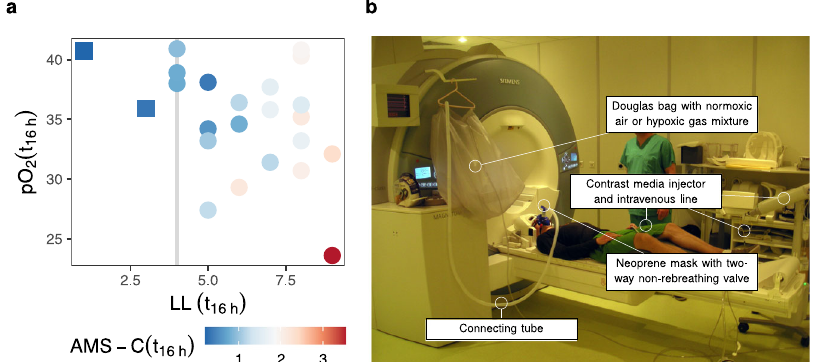
Fig. 3 Exposure to low atmospheric oxygen and acute mountain sickness (AMS). a Single participants ’ arterial oxygen levels (pO 2 ) as a function of their Lake Louise (LL) scores, a clinical measure of AMS, both measures are taken after 16 h of hypoxic exposure. Scores equal or above 4 indicate the presence of AMS. Marker colors correspond to AMS-C scores, a second clinical measure of AMS, scores above 0.7 indicate the presence of AMS. b To induce normobaric hypoxia, participants were exposed to an atmosphere corresponding to that at 4500 m altitude for 16 h. During MR measurements, participants wore a neoprene mask with a two-way non-rebreathing valve connected to a Douglas bag. Under normoxia conditions, the bag was fi lled